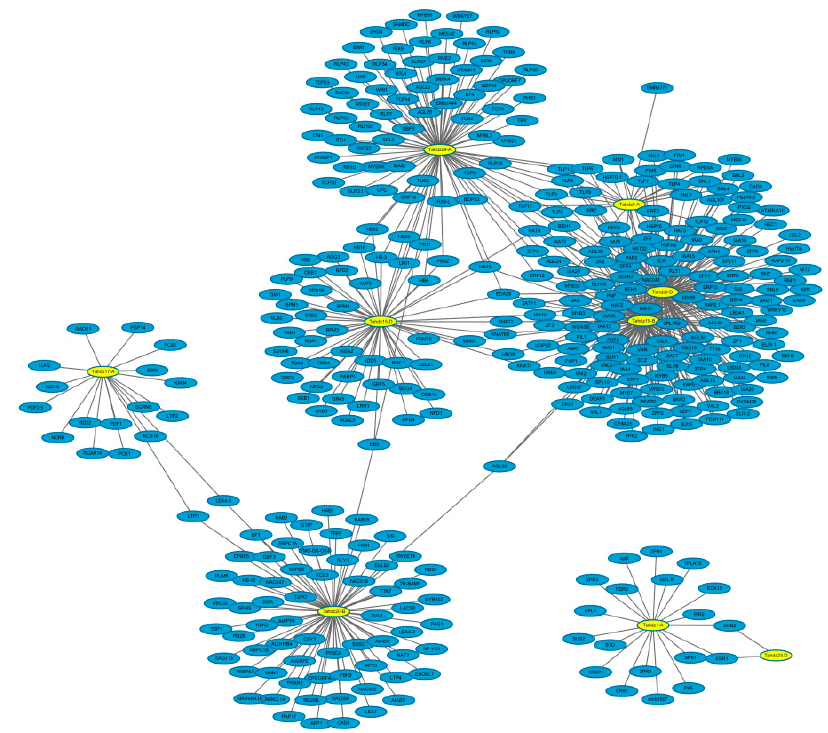
Figure 4. The co-expression network of TaHDZ genes in wheat according to the orthologues in Arabidopsis.